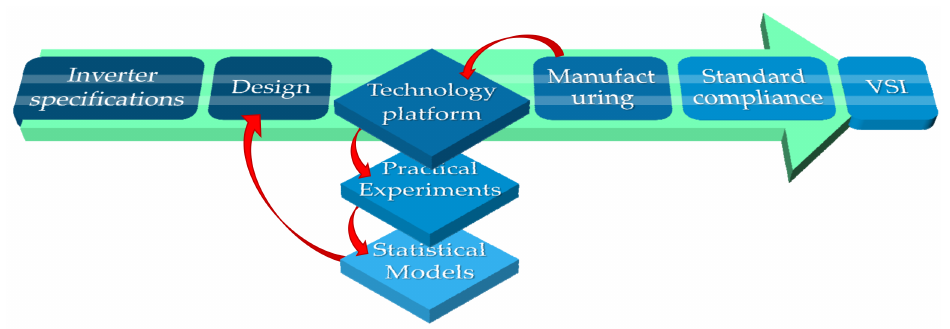
Figure 6. Simplified workflow of the AD